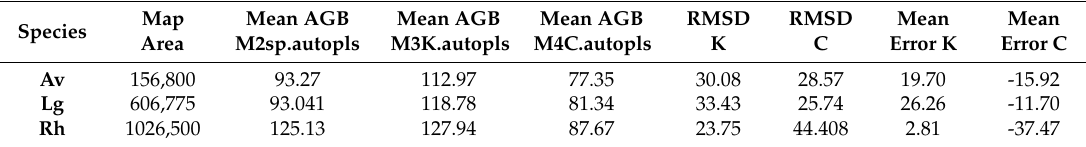
Table 7. AGB map of error for analysis of each class of mangrove